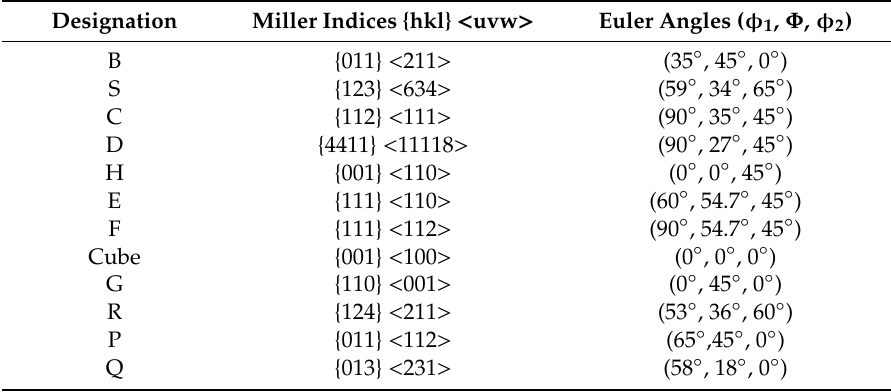
Table 2. Major texture components in face-centered cubic (fcc) material